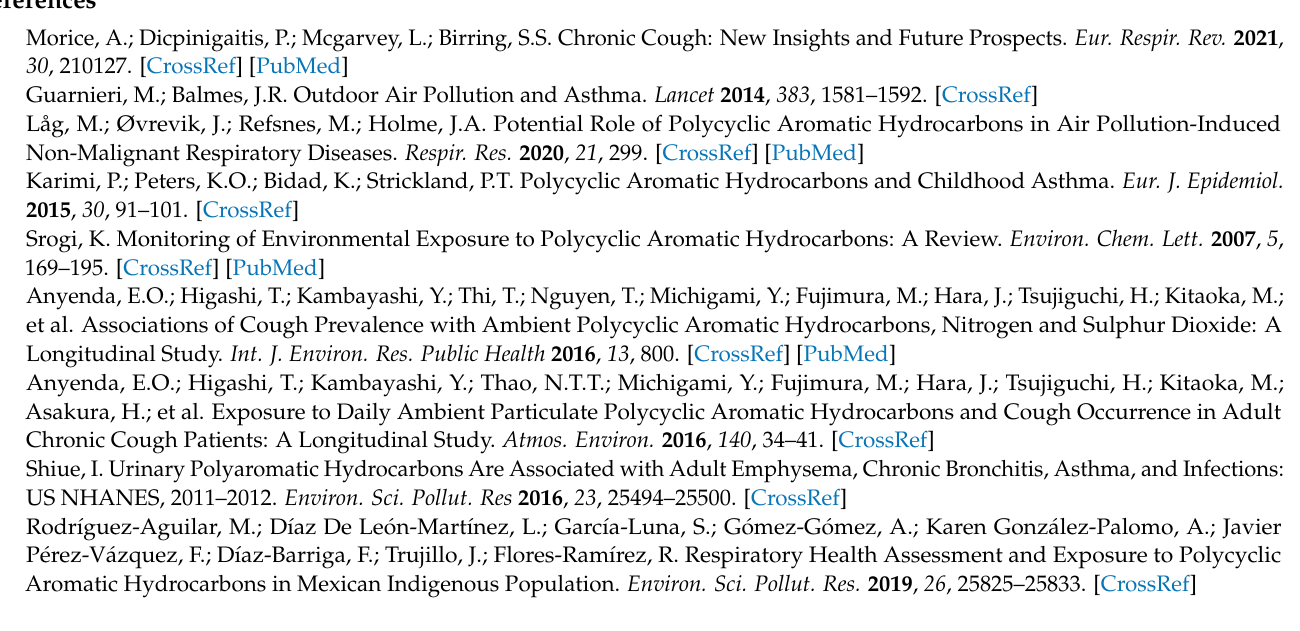
Table S3: Adjusted estimates of cough symptoms in total PAH exposure in the GEE lag 3 model; Table S4: Adjusted estimates of cough symptoms in total PAH exposure in the GEE lag 4